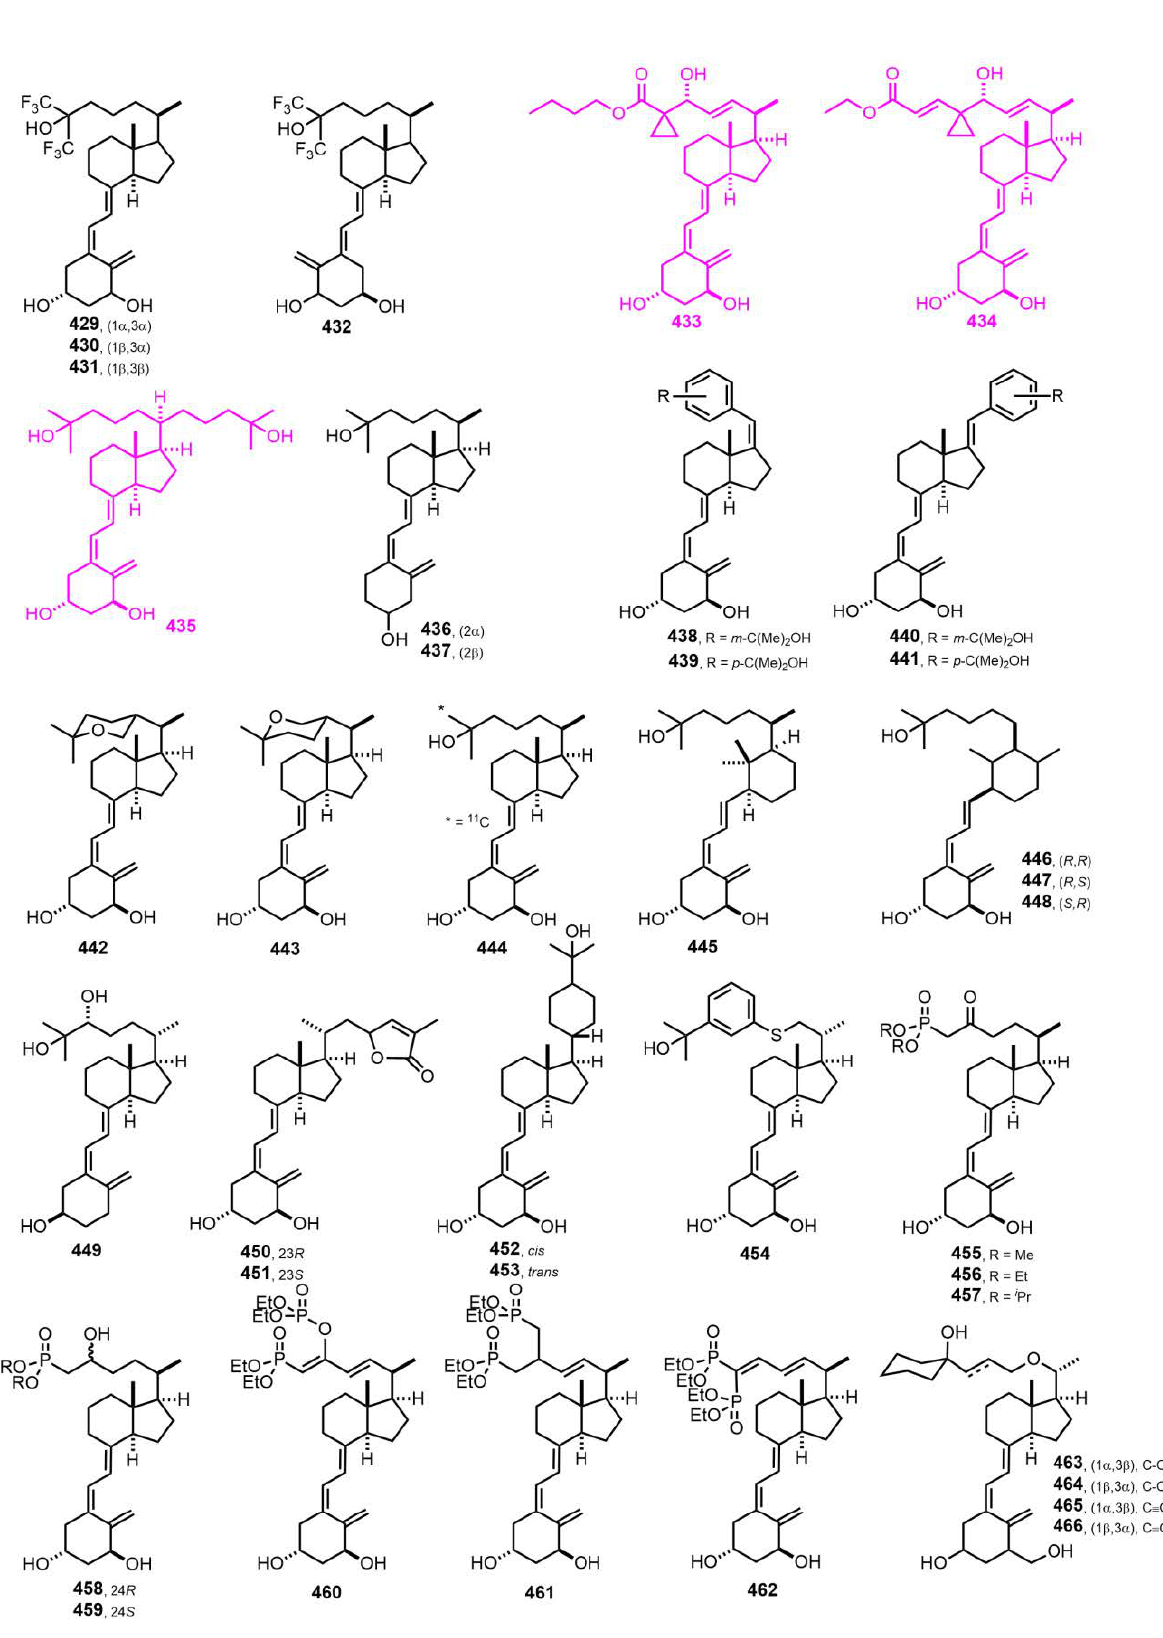
Figure 10. (2000–2001)